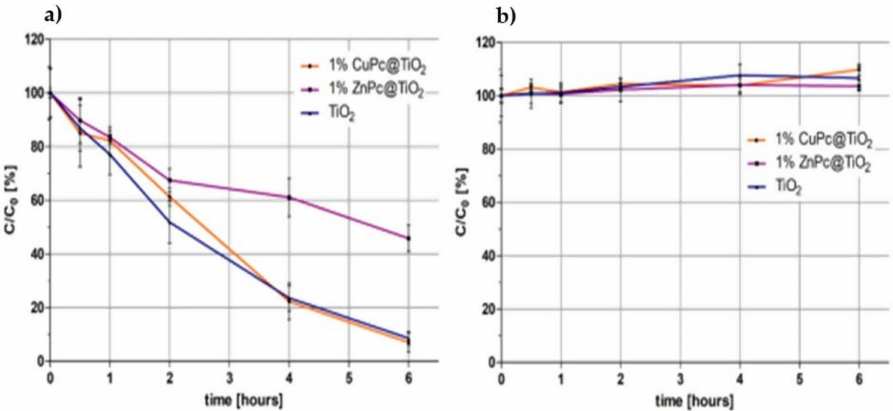
Figure 7. The changes in IBU concentration after irradiation of the solution containing photocatalyst at ( a ) 365 nm light and ( b ) 665 nm light. Adapted with permission from ref. [20]. Copyright 2020